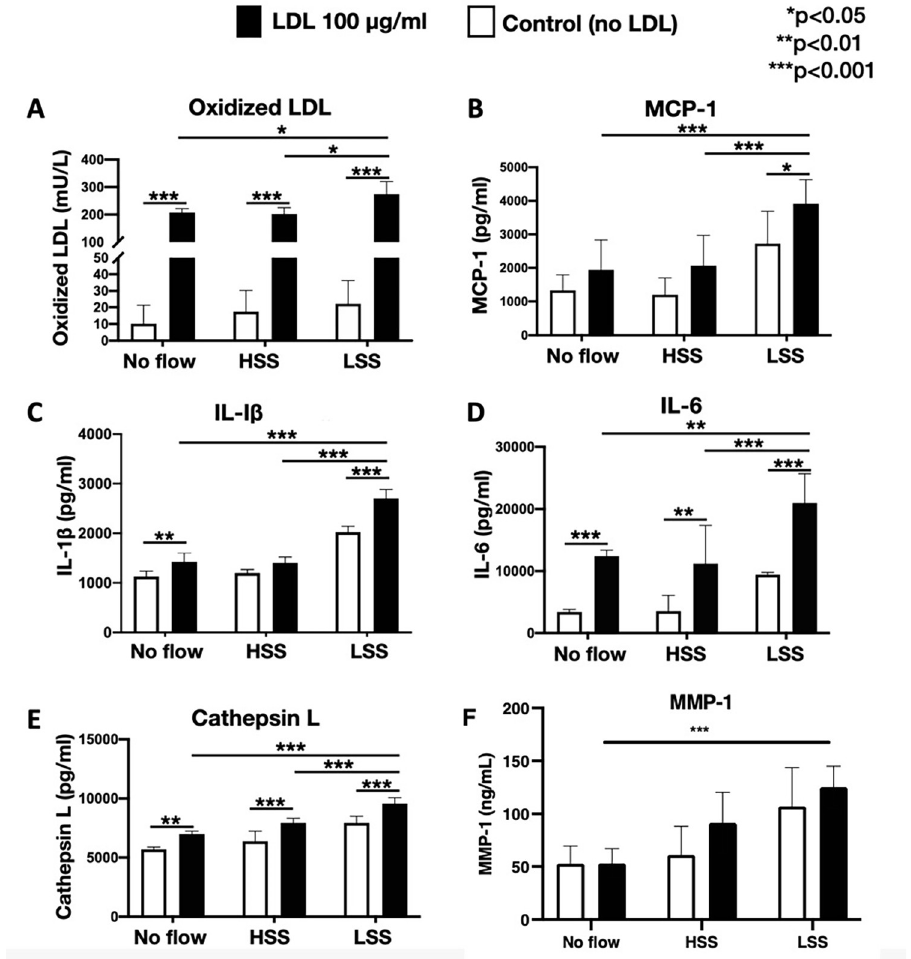
Fig 7. Effects of shear stress and native LDL on the release of oxidized LDL, expression of pro-inflammatory molecules, and matrix-degrading enzymes. A : Low shear stress significantly increased the expression of oxidized LDL in the co-culture medium of model #4, compared to high shear stress or static controls, B-F: Similarly, expression of MCP-1, IL-1ß, IL-6, cathepsin L, and MMP-1 was increased in cultures exposed to low shear stress, compared to high shear stress or static controls (white bars). Notably, addition of LDL in the medium significantly augmented the expression of oxidized LDL, MCP-1, IL-1ß, IL-6, cathepsin L, and MMP-1 (black bars; LDL: low-density lipoproteins; MCP-1: monocyte chemoattractant protein 1; IL: interleukin; MMP: matrix metalloproteinases) � p < 0.05; �� p < 0.01; ��� p <